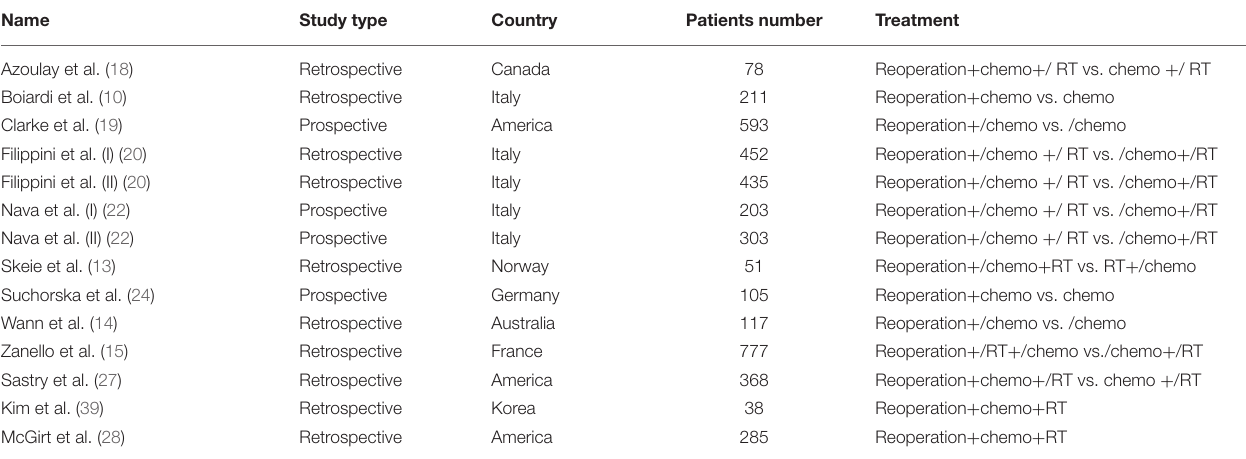
TABLE 2 | Characteristics of included studies for post-progression survival